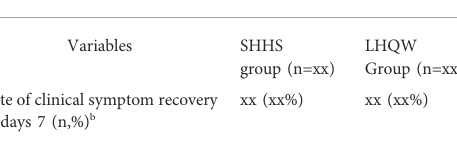
TABLE 3 Analysis of the primary outcome.